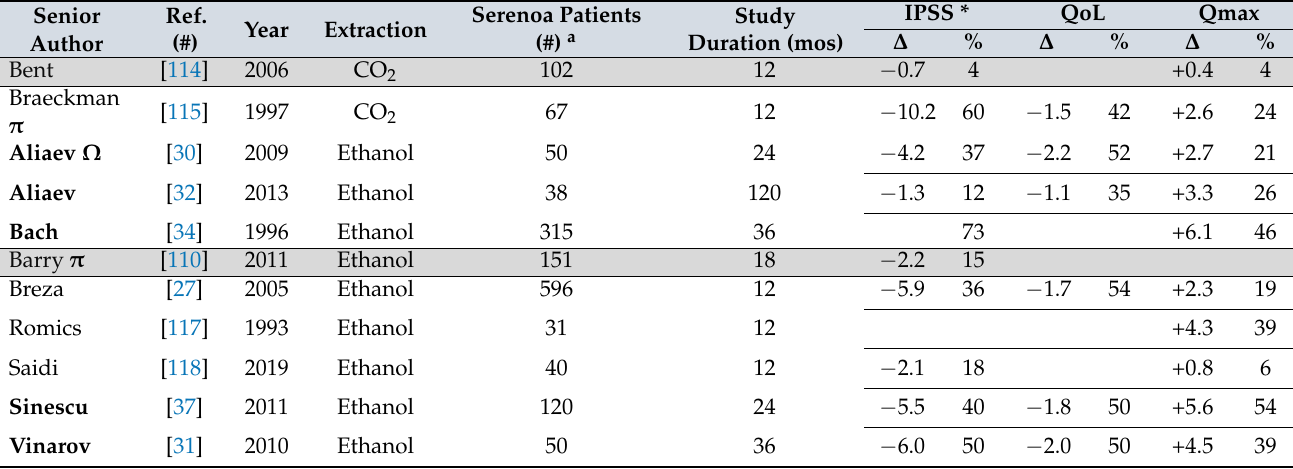
Table 2. Long-term ( ≥ 12 months) studies using LSESr. Seventeen studies of ≥ 12 months involving all extraction technologies (CO 2 , ethanol, hexane) with calculated average values across all studies. Nine studies of ≥ 2 years show the first author in bolded font. The two negative studies by Bent 2006 and Barry 2001 are shaded in green. IPSS * QoL